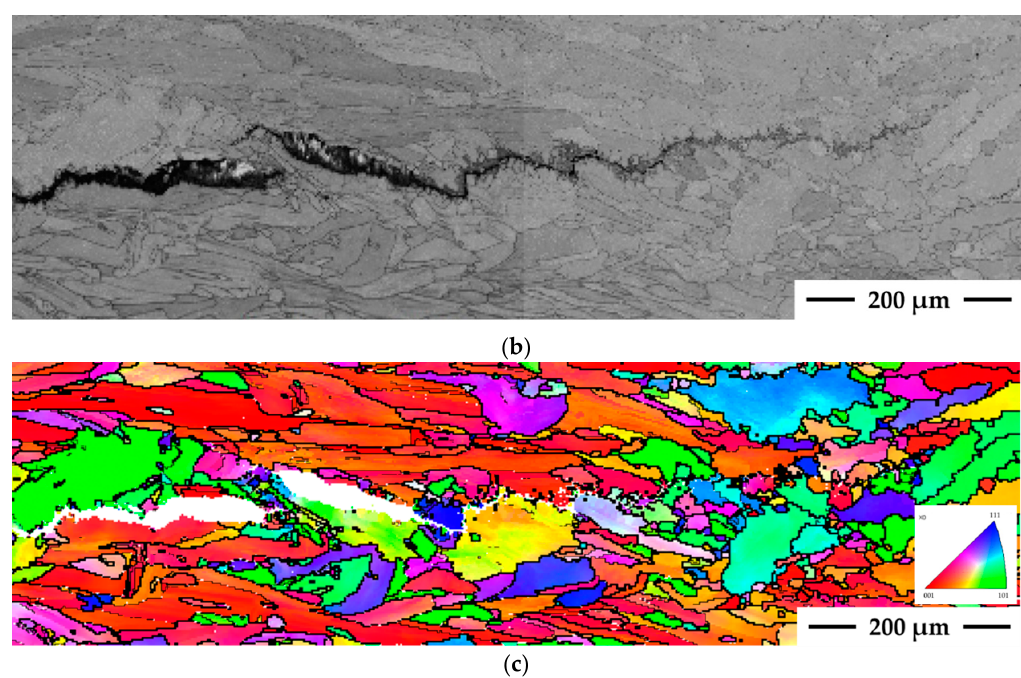
Figure 5. ( a ) Optical micrograph showing base metal (BM), heat affected zone (HAZ), partially melted zone (PMZ), and fusion zone (FZ) of the specimen welded transverse to the sample building direction (BD) (Note: the welding direction (WD) is transverse to the grain orientation). ( b ) SEM micrograph showing the unetched microstructure of the welded sample. ( c ) EBSD inverse pole figure (IPF) coloring mapping of the same image as ( b ).